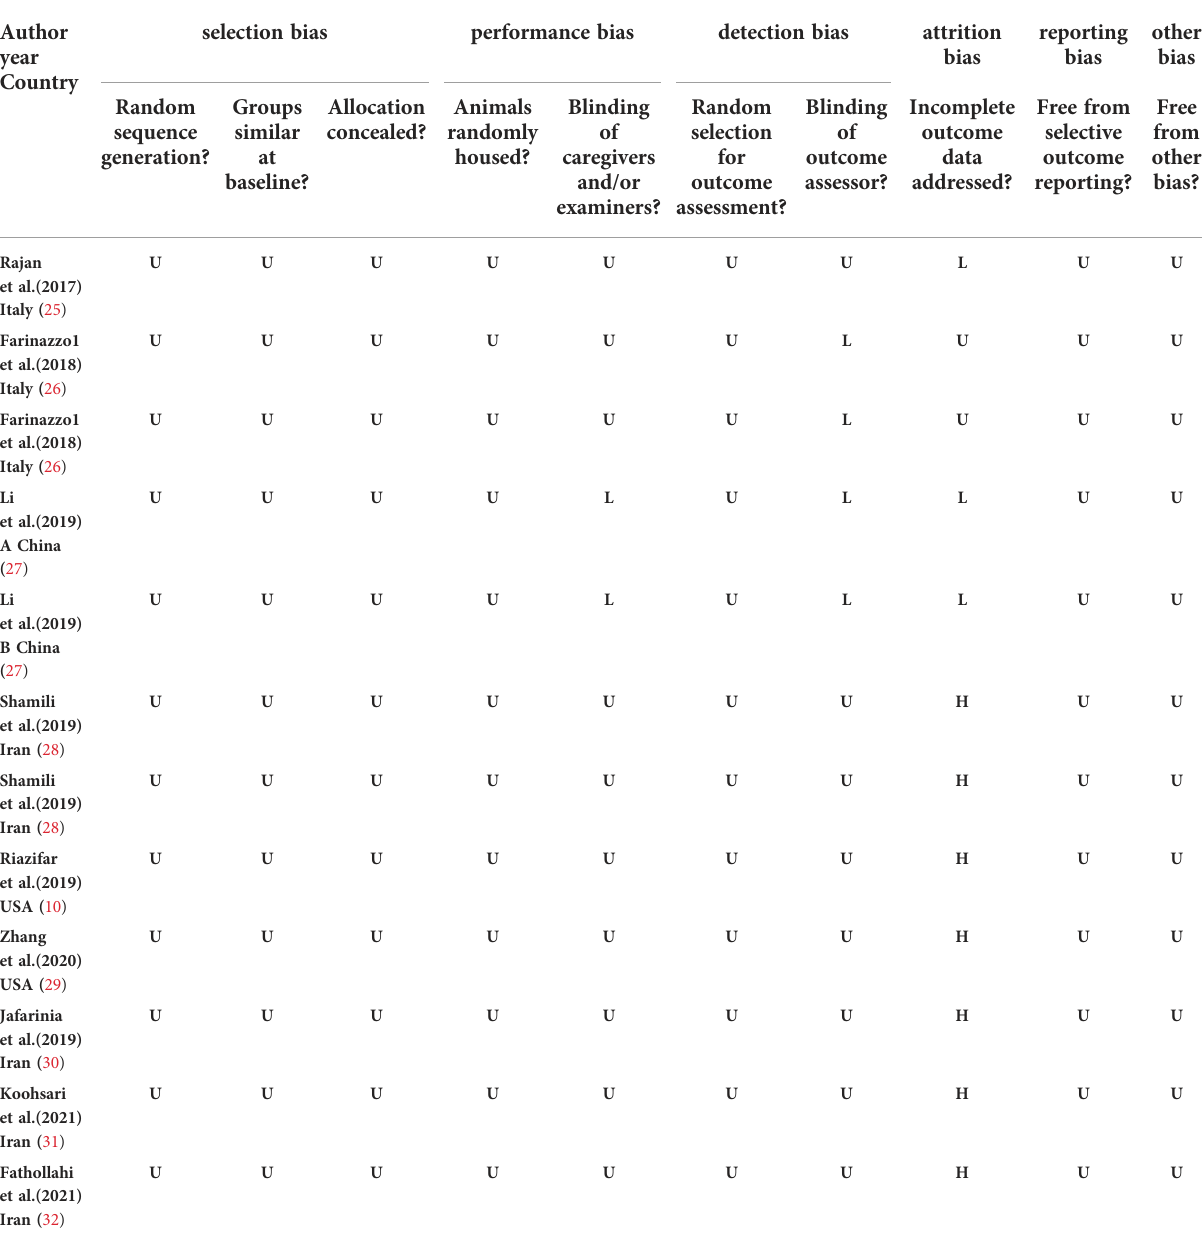
TABLE 2 SYRCLE risk of bias assessment for included